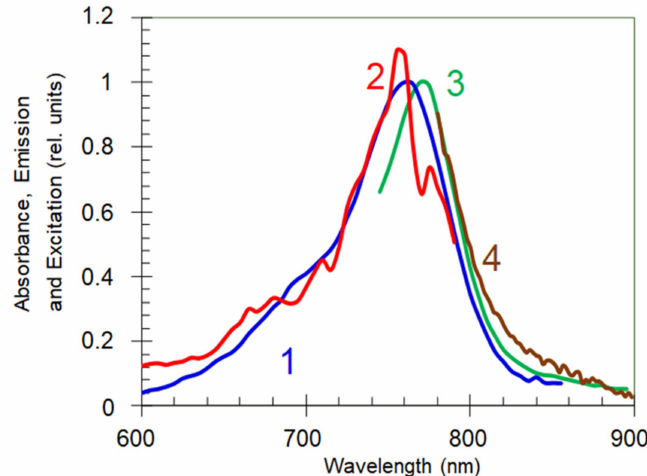
Figure 2. Absorption (trace 1), excitation (trace 2) and cw emission (trace 3) spectra of HITC:PMMA film on the glass substrate at the dye concentration equal to 8.5 g / L. Trace 4: emission spectrum at short-pulse pumping. Reproduced with permission of [16] 2019. The Optical